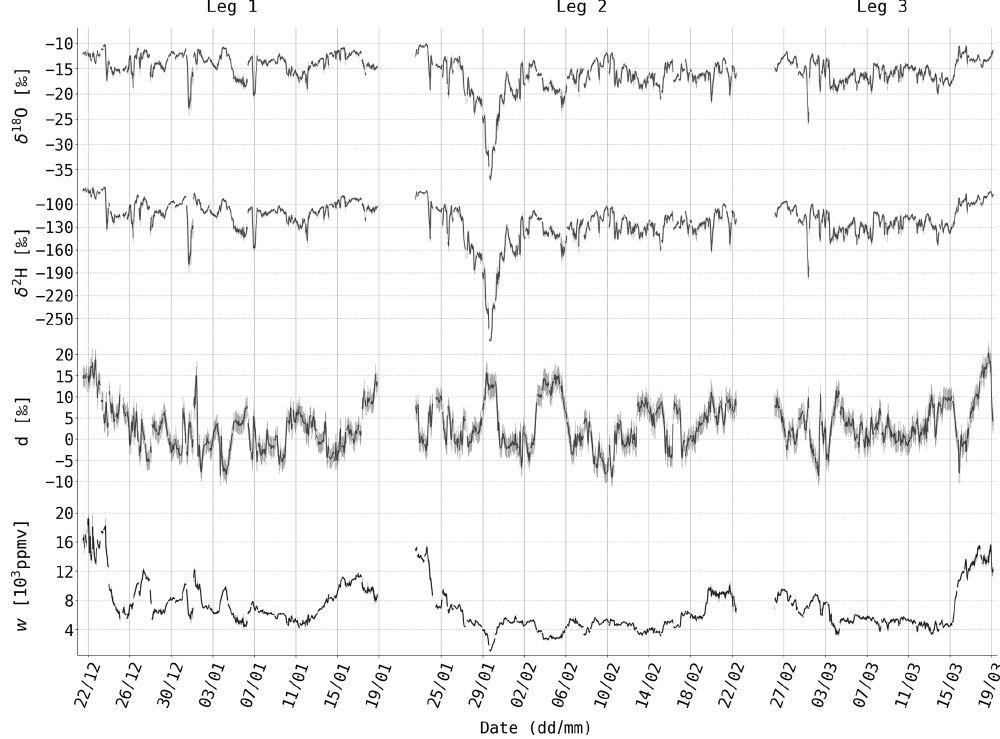
Figure 5. Time series of hourly δ 18 O, δ 2 H, d and w for legs 1–3 from SWI-13. The error bars denote hourly standard deviations of the 1s